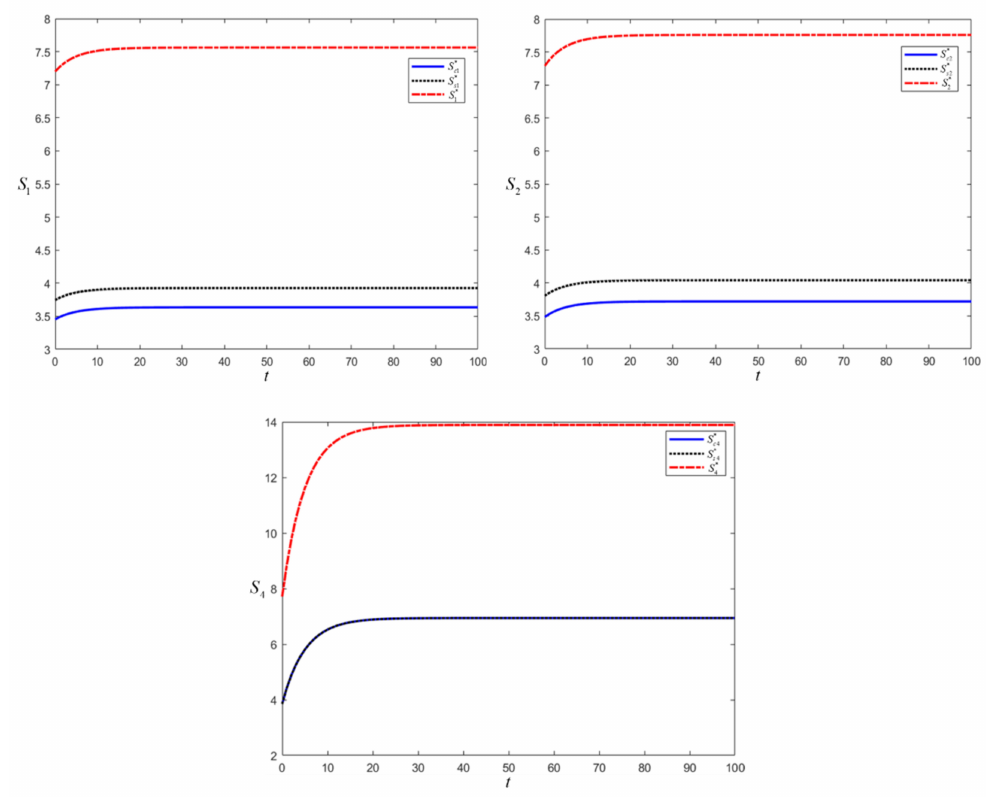
Figure 1. Optimal revenue function of manufacturer, EP and SC under three game